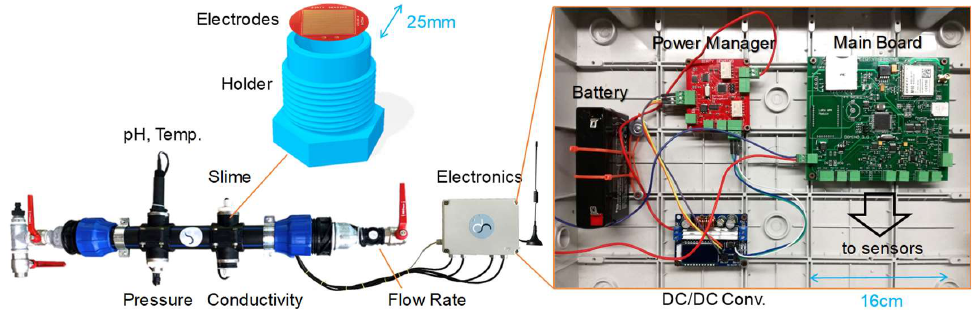
Figure 4. Photograph of the fully assembled node, showing the in-line sensors, the plastic holder of the slime monitor, the electronic boards, and the GSM antenna. slime monitor, the electronic boards, and the GSM